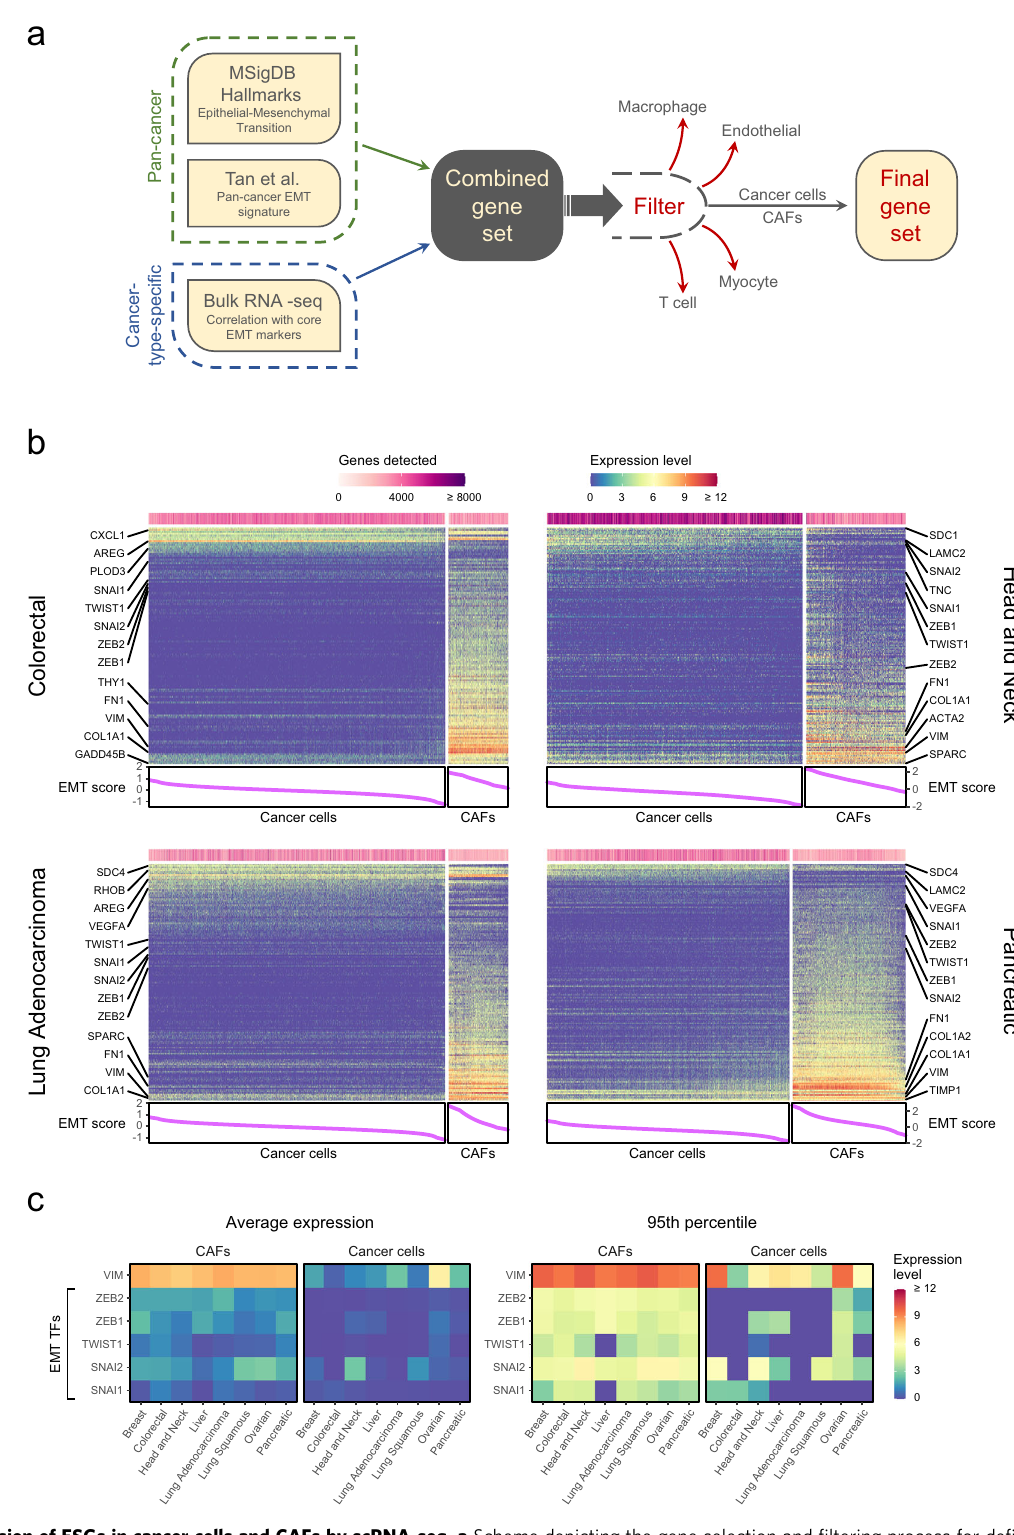
Fig. 1 Expression of ESGs in cancer cells and CAFs by scRNA-seq. a Scheme depicting the gene selection and fi ltering process for de fi ning cancer type- speci fi c lists of EMT signature genes (ESGs). b Heatmaps showing expression levels of ESGs (rows) in cancer cells and CAFs (columns) in 4 scRNA-seq datasets (panels) out of the 8 considered (the remaining 4 are shown in Fig. S4). Columns (cells) are ordered by their EMT scores (see Methods), which are shown in the line graphs below the heatmaps. The bar above each heatmap shows the number of genes detected in each cell. c Heatmaps showing the average and 95 th percentile of the expression levels of each of the core EMT TFs and Vimentin in cancer cells and CAFs in each of the 8 scRNA-seq